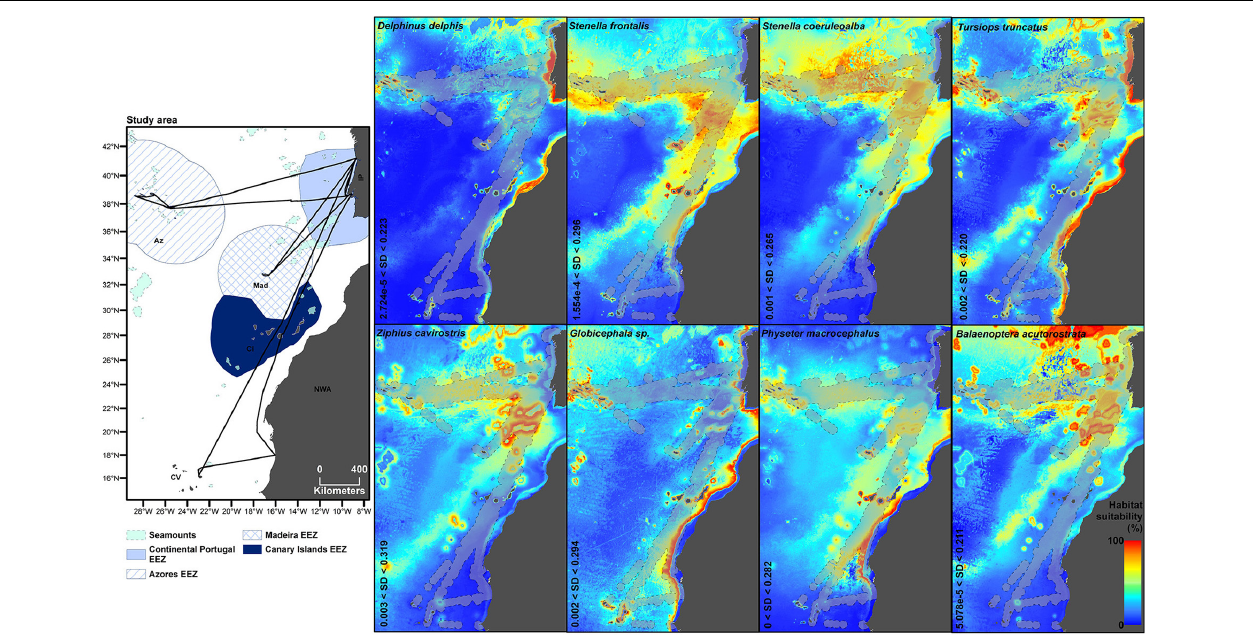
FIGURE 2 | Averaged maps of the eight final niche models obtained with Maxent. The range of standard deviation (SD) of each model is at the bottom left margin of the maps. The 50 km buffer around each presence point is in light grey delimited by dashed